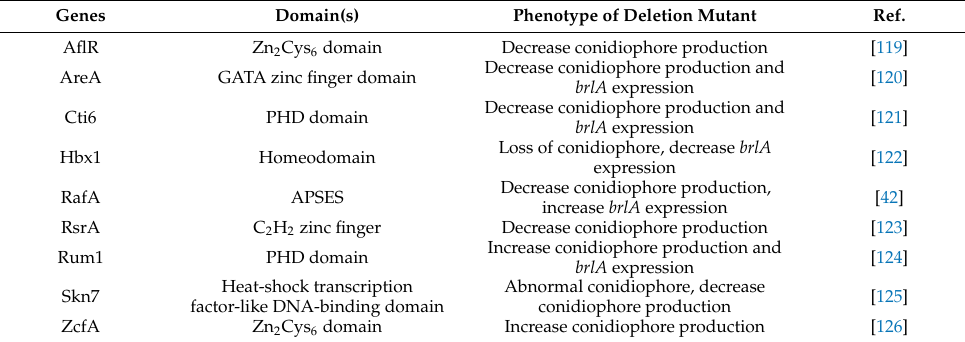
Table 3. The function of transcription factors related to A. flavus conidiation. Genes Domain(s) Phenotype of Deletion Mutant Ref. AflR Zn 2 Cys 6